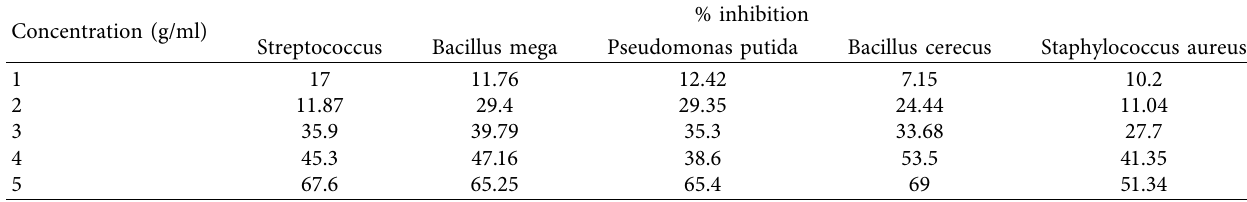
Table 7: % inhibition by tube dilution